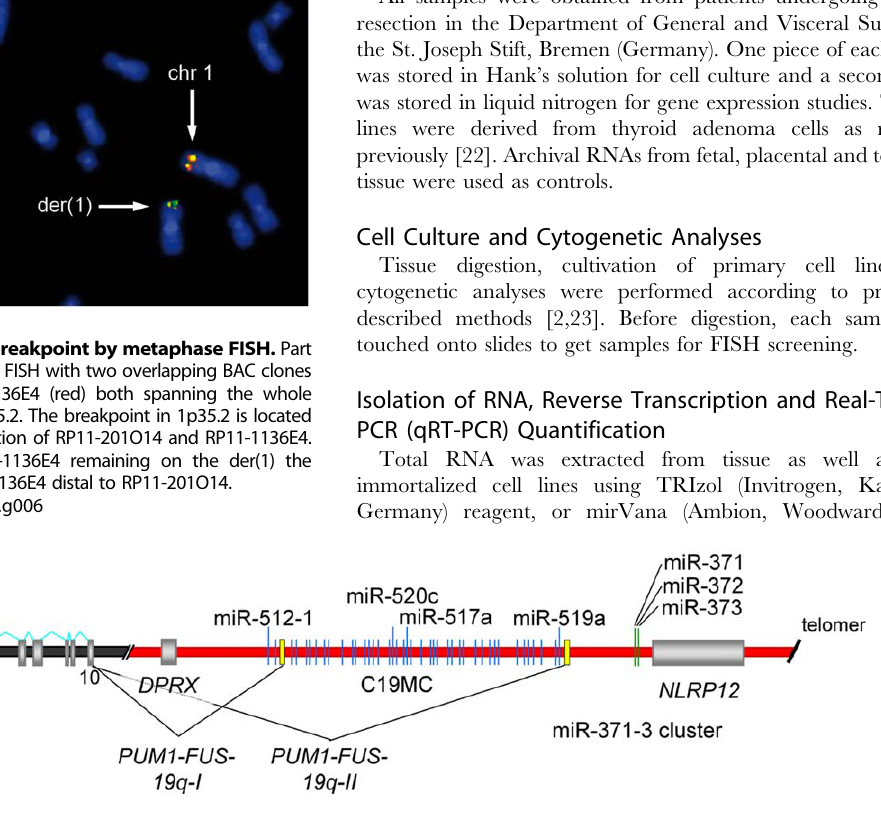
Figure 7. Genomic organization of the fusion gene on the derivative chromosome 1 resulting from a translocation t(1;19)(p35.2;13.4) in cell line S40.2. Detailed schematic overview illustrating the origin of the fusion transcripts PUM1-FUS-19q-I (Genbank Accession number GQ334687) and PUM1-FUS-19q-II (Genbank Accession number GQ334688) identified in cell line S40.2. The genomic region of PUM1 in 1p35.2 (horizontal gray bar) fuses after exon 10 of PUM1 (exons: vertical light gray bars) to the genomic region of C19MC in 19q13.4 (horizontal red bar). The two vertical yellow bars indicate 3 9 -sequences located after exon 1–10 of PUM1 in PUM1-FUS-19q-I and PUM1-FUS-19q-II , respectively, both originating from alternative splicing. The fusion transcripts were detected either by 3 9 -RACE-PCR ( PUM1-FUS-19q-I ) or RT-PCR ( PUM1-FUS-19q-II ) experiments. The quantified miRNAs have been highlighted by their names.